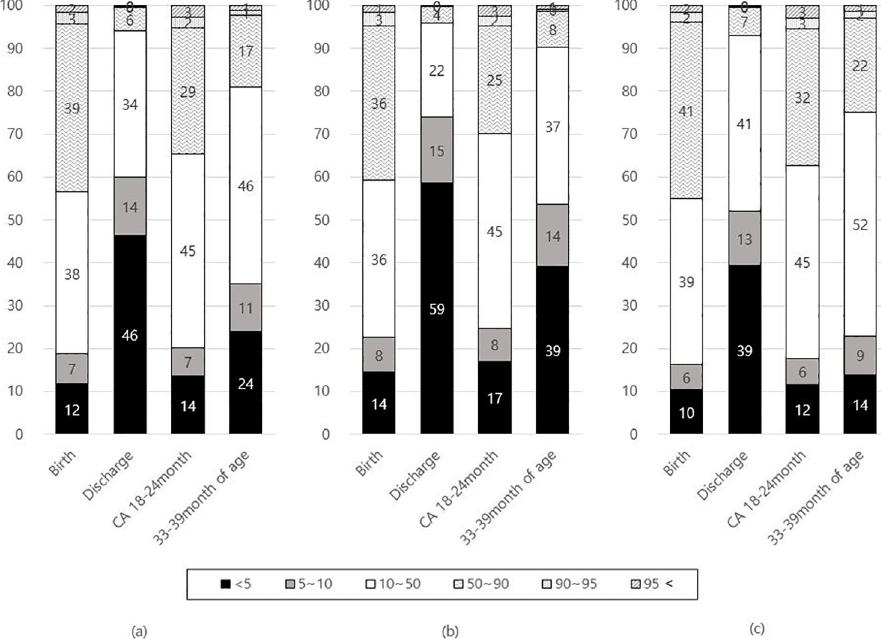
Fig 2. Proportions of weight percentiles at birth, discharge, follow-up 1, and follow-up 2 according to birth weight among VLBW infants (a), ELBW infants (b), and the infants with birth weight between 1000 and 1499g